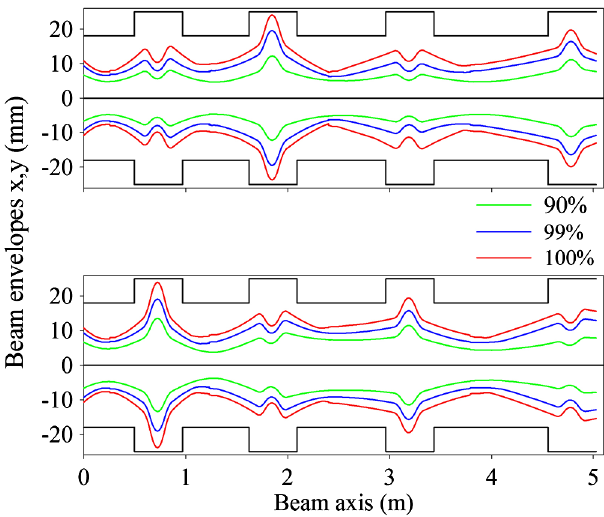
FIG. 26. Transverse 90%, 95%, and 100% beam envelopes starting 60 mm behind the solenoid. Black lines indicate the